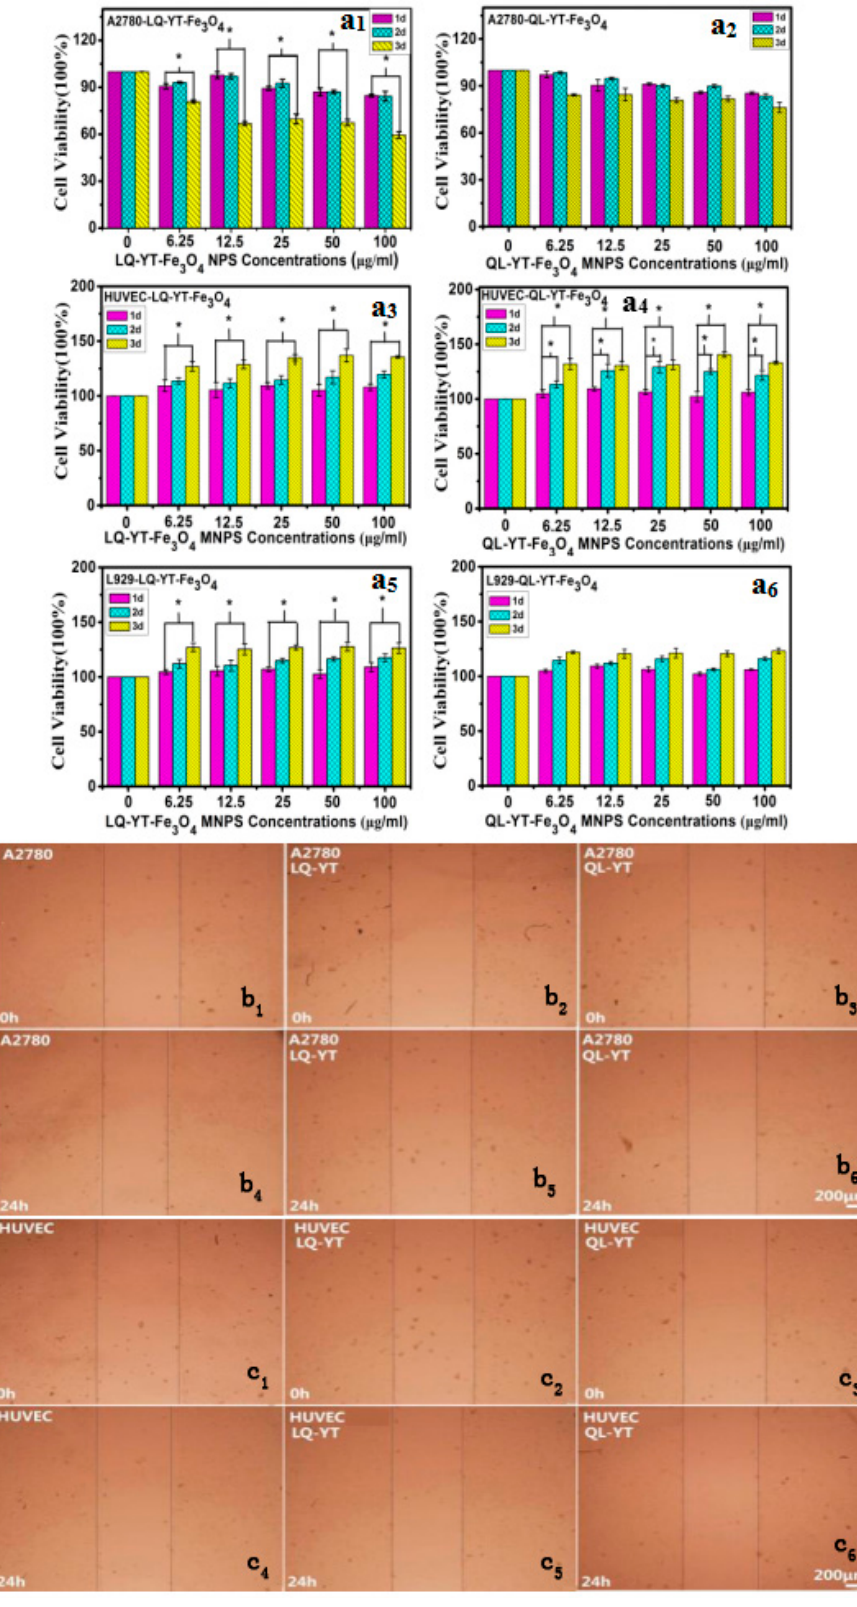
Figure 6. ( a 1 – a 6 ) MTT charts of LQ-YT-modified Fe 3 O 4 -MNPs and QL-YT-modified Fe 3 O 4 -MNPs; ( b 1 – b 6 ) scratch wound migration images of A2780 incubated with LQ-YT- and QL-YT-modified Fe 3 O 4 -MNPs; ( c 1 – c 6 ) scratch wound migration images of HUVECs incubated with LQ-YT- and QL-YT-modified Fe 3 O 4 -MNPs.